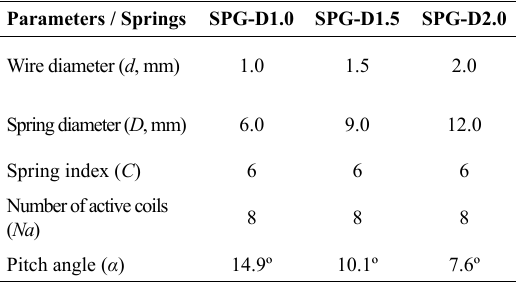
Table 1. Spring geometric parameters.